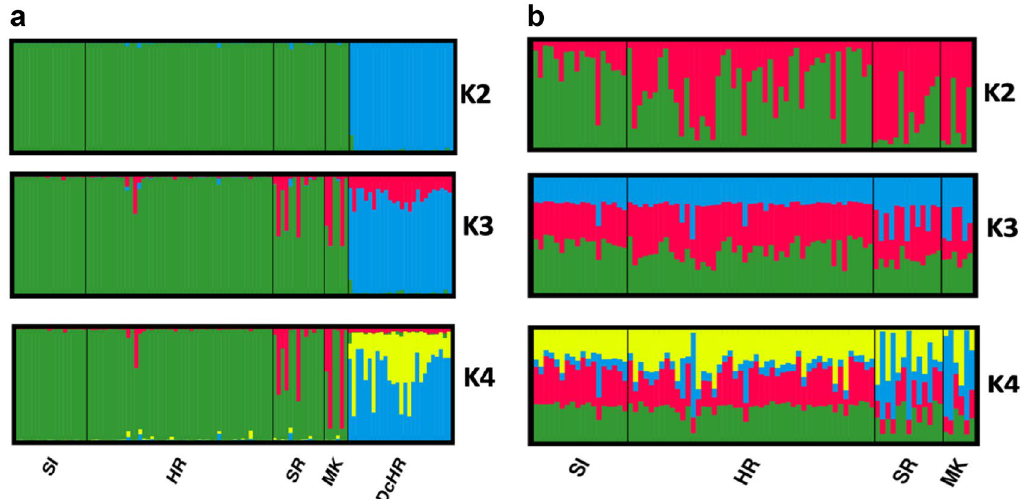
Figure 1. Genetic structure of European wildcat populations from Slovenia (SI), Croatia (HR), Serbia (SR), North Macedonia (MK) and domestic cats (DcHR)) ( a ) and only European wildcat populations ( b ) revealed by STRU CTU RE) (see Table 4.) Each individual is represented by a line proportionally partitioned into colour segments corresponding to its membership in particular clusters. K is the number of clusters. Black lines separate the individuals from different populations (according to Table